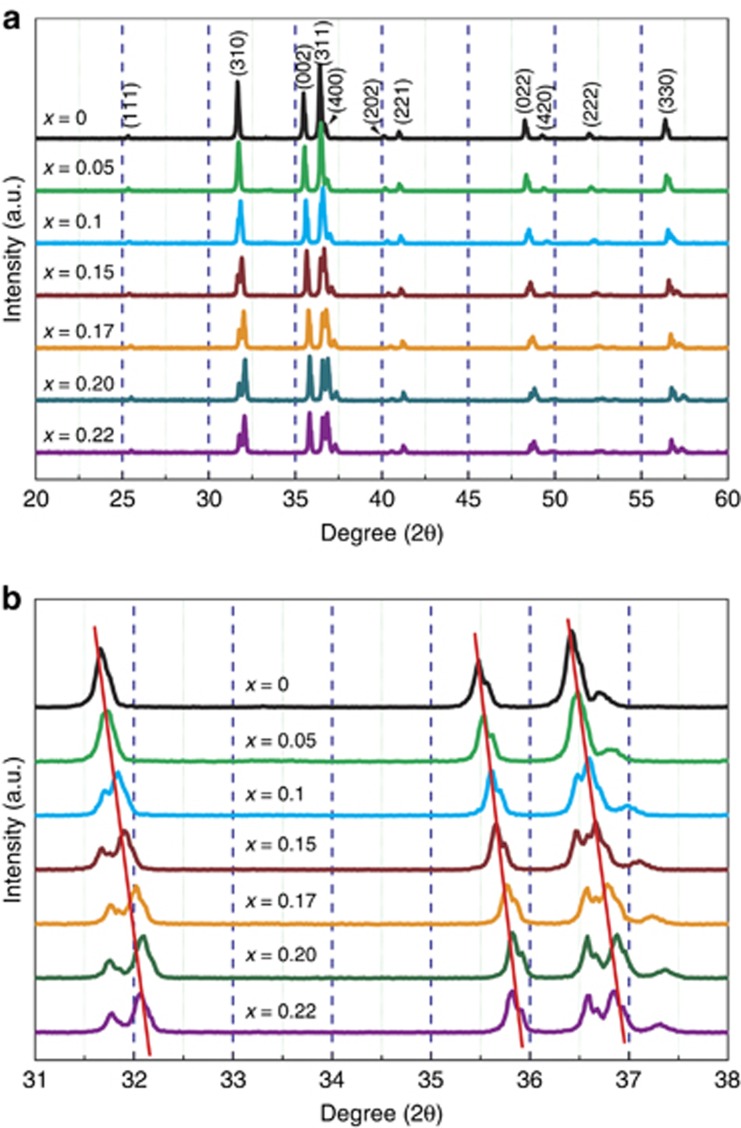
(a) XRD patterns of samples of Ca1−xLixAl1−xSi1+xN3 with varying x and (b) enlarged XRD patterns of the portion marked in a, showing the diffraction peak splitting with increasing x.